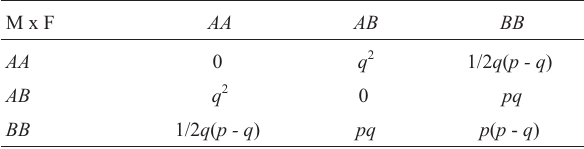
Table 4 - Mating scheme with F = 1/2 ( p - q )/ p , G = 0, s = 0 and t = q 2 . M x